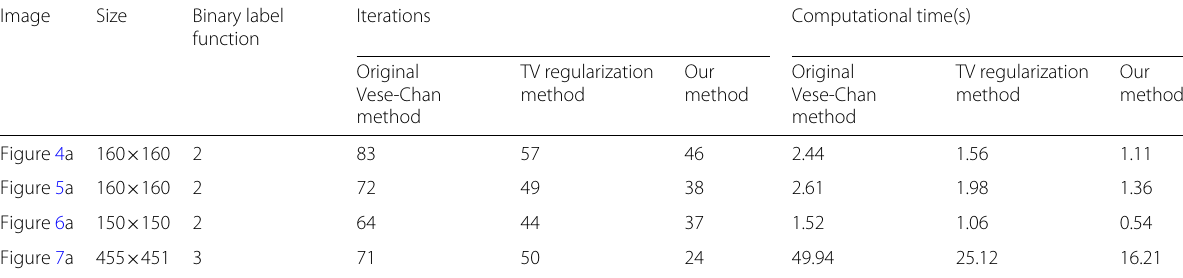
Table 3 Iterations and computational time for Figs. 4a, 5a, 6a , and 7a Image Size Binary label function